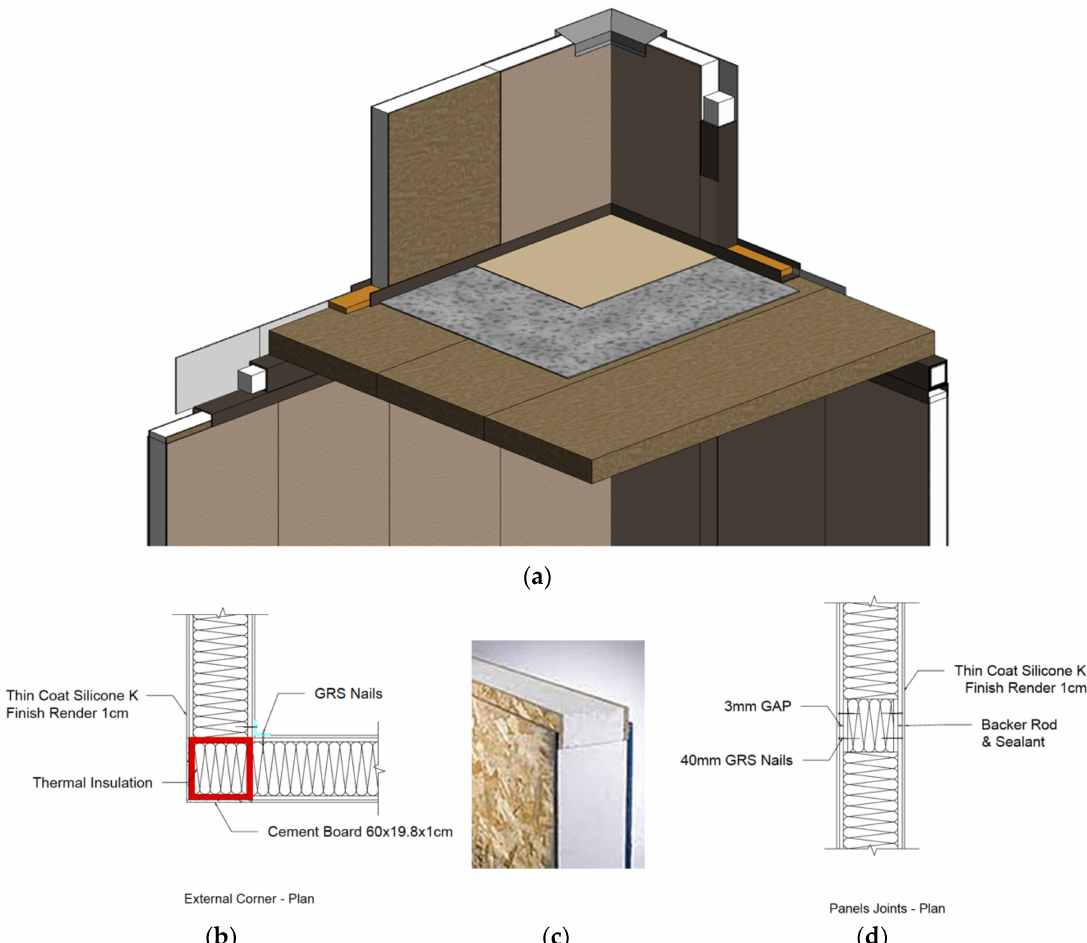
Figure 9. ( a ) 3D detail for the wall and floor SIPs, ( b ) external corner detail, ( c ) 3D image of the block spline joint, ( d ) block spline joint construction